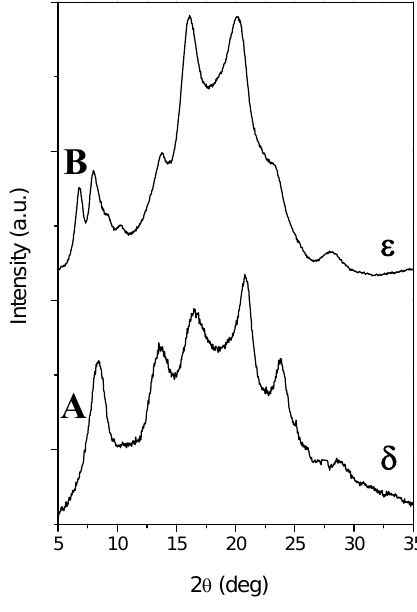
Figure 1. X-ray diffraction patterns (CuK α ) of s-PS semicrystalline powder samples presenting the two nanoporous crystalline phases: (A) δ -form; (B) ε